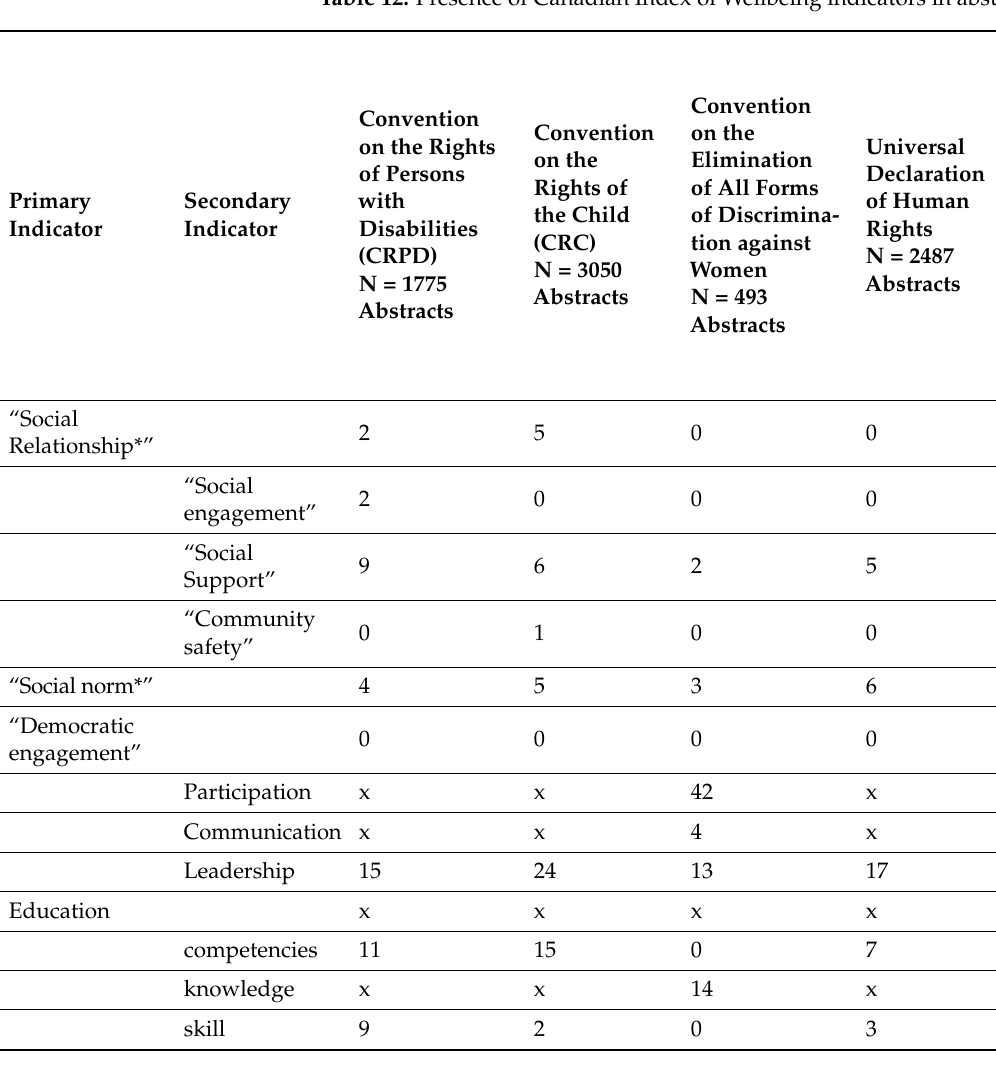
Table 12. Presence of Canadian Index of Wellbeing indicators in abstracts mentioning “the